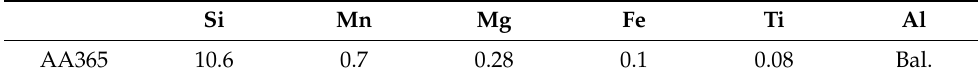
Table 1. Chemical composition of AA365 aluminum alloy. Si Mn Mg Ti